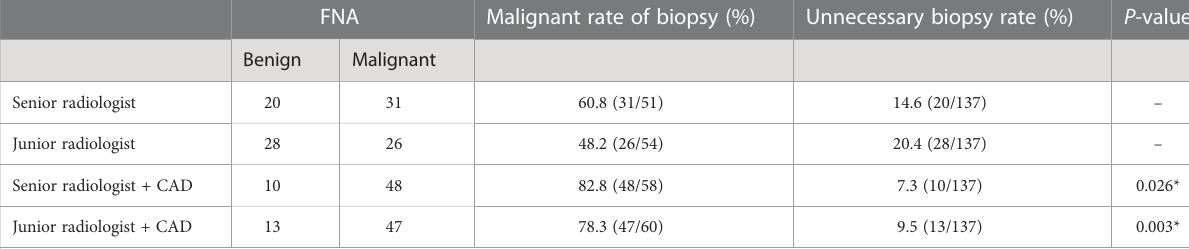
TABLE 7 The effectiveness of the CAD system in assisting junior and senior radiologists in FNA.